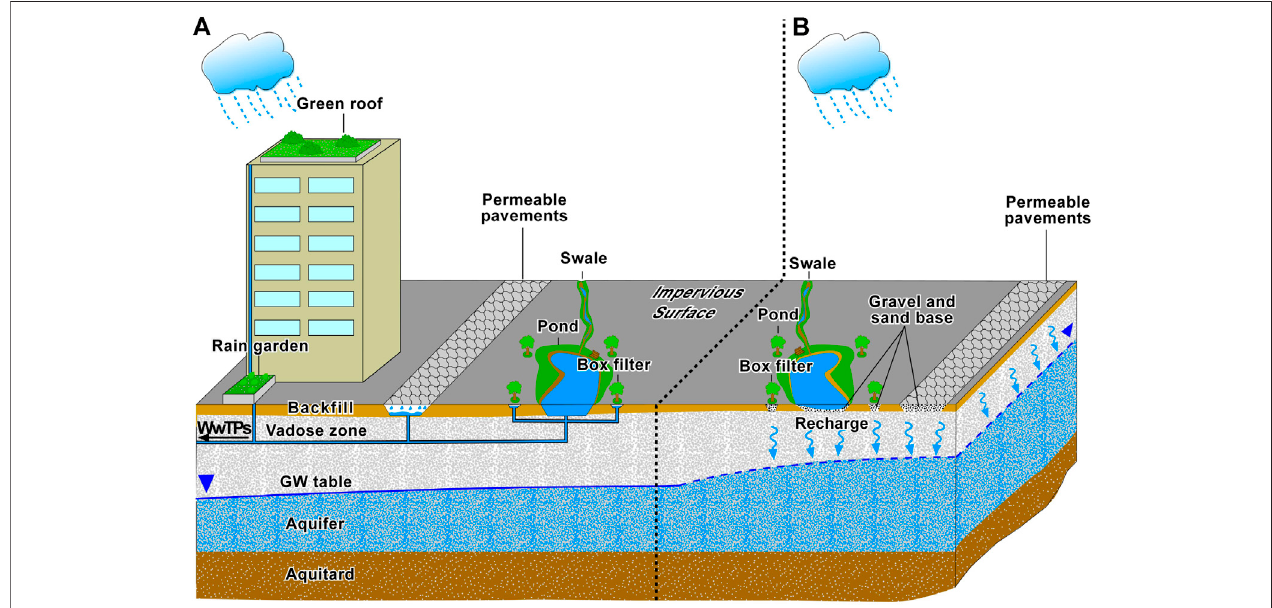
FIGURE 2 | Classic Sponge City design with water collected via pipes and tanks (A) ; in fi ltration-based installations, back fi ll continuity is interrupted by a base of gravel and sand favoring in fi ltration (B) .